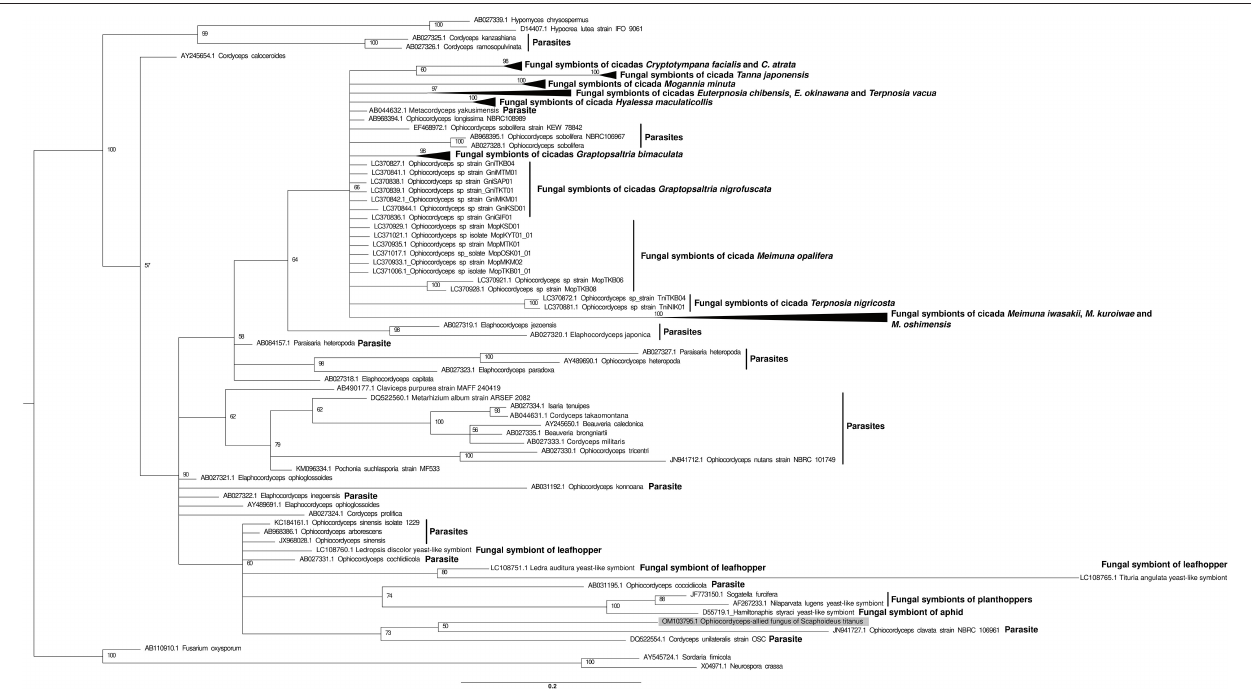
FIGURE 1 | Phylogenetic relationships of the Ophiocordyceps- allied fungus of S. titanus . A Bayesian phylogeny with 10 7 generations based on the Hypocreales 18S rRNA gene sequences (provided by Matsuura et al., 2018) is shown. The sequences from Neurospora crassa and Sordaria fimicola (both belonging to the order Sordariales) were used as outgroups. The Ophiocordyceps- allied fungus of S. titanus is highlighted in a gray box. The collapsed branch named “Fungal symbionts of the cicadas Graptopsaltria bimaculata and G. nigrofuscata” grouped 11 sequences: LC370827.1 Ophiocordyceps sp strain GniTKB04, LC370836.1 Ophiocordyceps sp strain GniGIF01, LC370841.1 Ophiocordyceps sp strain GniMTM01, LC370839.1 Ophiocordyceps sp strain GniTKT01, LC370842.1 Ophiocordyceps sp strain GniMKM01, LC370838.1 Ophiocordyceps sp strain GniSAP01, LC370844.1 Ophiocordyceps sp strain GniKSD01, LC370858.1 Ophiocordyceps sp strain GbiAMM01, LC370850.1 Ophiocordyceps sp strain GbiNNJ01, LC370857.1 Ophiocordyceps sp strain GbiTKN01, LC370859.1 Ophiocordyceps sp strain GbiOGM01. The collapsed branch named “Fungal symbionts of the cicada Hyalessa maculaticollis” grouped five sequences: LC370989.1 Ophiocordyceps sp strain HmaMTK01, LC370983.1 Ophiocordyceps sp strain HmaTKB05, LC370991.1 Ophiocordyceps sp strain HmaMTM01, LC370994.1 Ophiocordyceps sp strain HmaOTR01, LC370993.1 Ophiocordyceps sp strain HmaSap01. The collapsed branch named “Fungal symbionts of the cicada Mogannia minuta” grouped three sequences: LC370996.1 Ophiocordyceps sp strain MmiIRO03, LC370997.1 Ophiocordyceps sp strain MmiKom01, LC370999.1 Ophiocordyceps sp strain MmiNNJ01. The collapsed branch named “Fungal symbionts of the cicada Cryptotympana facialis” grouped 10 sequences: LC370788.1 Ophiocordyceps sp strain CfaKSD05, LC370815.1 Ophiocordyceps sp strain CfaKWS02, LC370813.1 Ophiocordyceps sp strain CfaISG01, LC370809.1 Ophiocordyceps sp strain CfaNAH01, LC370796.1 Ophiocordyceps sp strain CfaOCP02, LC370806.1 Ophiocordyceps sp strain CfaTKT01, LC370811.1 Ophiocordyceps sp strain CfaISG01, LC370816.1 Ophiocordyceps sp strain CatKNZ01, LC370803.1 Ophiocordyceps sp strain CfaOKZ01, LC370825.1 Ophiocordyceps sp strain CatKNZ0. The collapsed branch named “Fungal symbionts of the cicadas Euterpnosia chibensis , E. okinawana and Terpnosia vacua” grouped four sequences: LC370894.1 Ophiocordyceps sp strain EokKNG01, LC370900.1 Ophiocordyceps sp strain EokKNG02, LC370888.1 Ophiocordyceps sp strain EUTCHI, LC370866.1 Ophiocordyceps sp strain TERVAC. The collapsed branch named “Fungal symbionts of the cicada Tanna japonensis” grouped three sequences: LC370902.1 Ophiocordyceps sp strain TjaTKB04, LC370916.1 Ophiocordyceps sp strain TjaSMR02, LC370909.1 Ophiocordyceps sp strain TjaYIT01. The collapsed branch named “Fungal symbionts of the cicadas Meimuna iwasakii , M. kuroiwae and M. oshimensis” grouped seven sequences: LC370967.1 Ophiocordyceps sp strain MiwITN01, LC370973.1 Ophiocordyceps